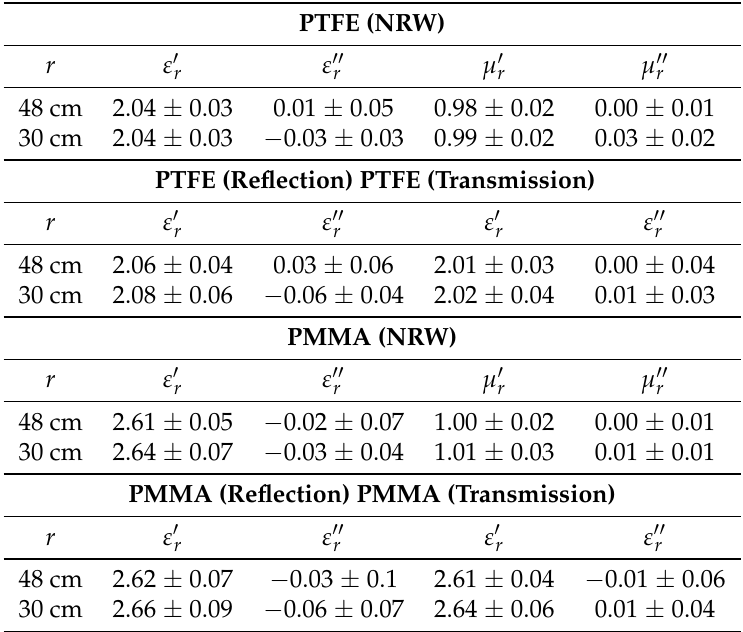
Table 2. The average and the standard deviation of the extracted parameters of the PTFE and PMMA samples, using the frequency-by-frequency approaches in two distances r